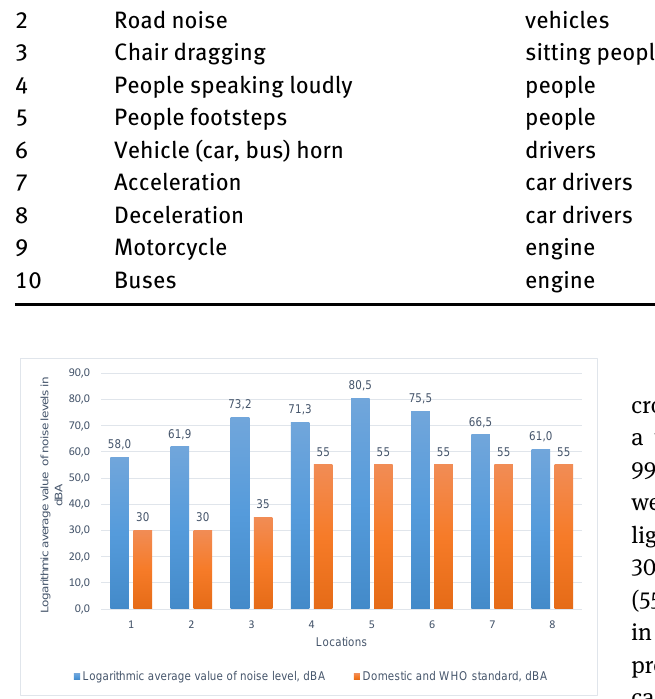
Figure 2: Logarithmic average value of noise levels, domestic and WHO standard for indoor and outdoor environments. Indoor envi- ronment locations are one, two and three. Outdoor environment locations are four, five, six, seven and